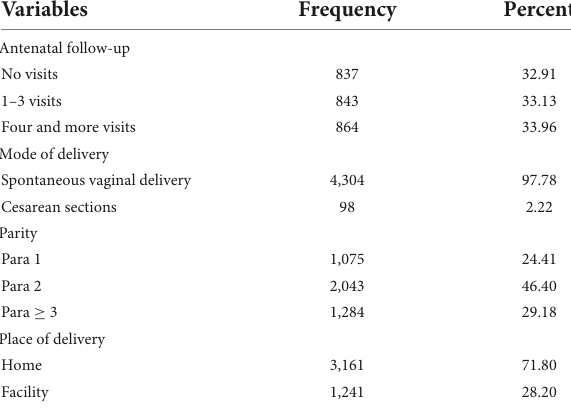
TABLE 2 Obstetric history of postnatal mothers in Ethiopia, 2016. Variables